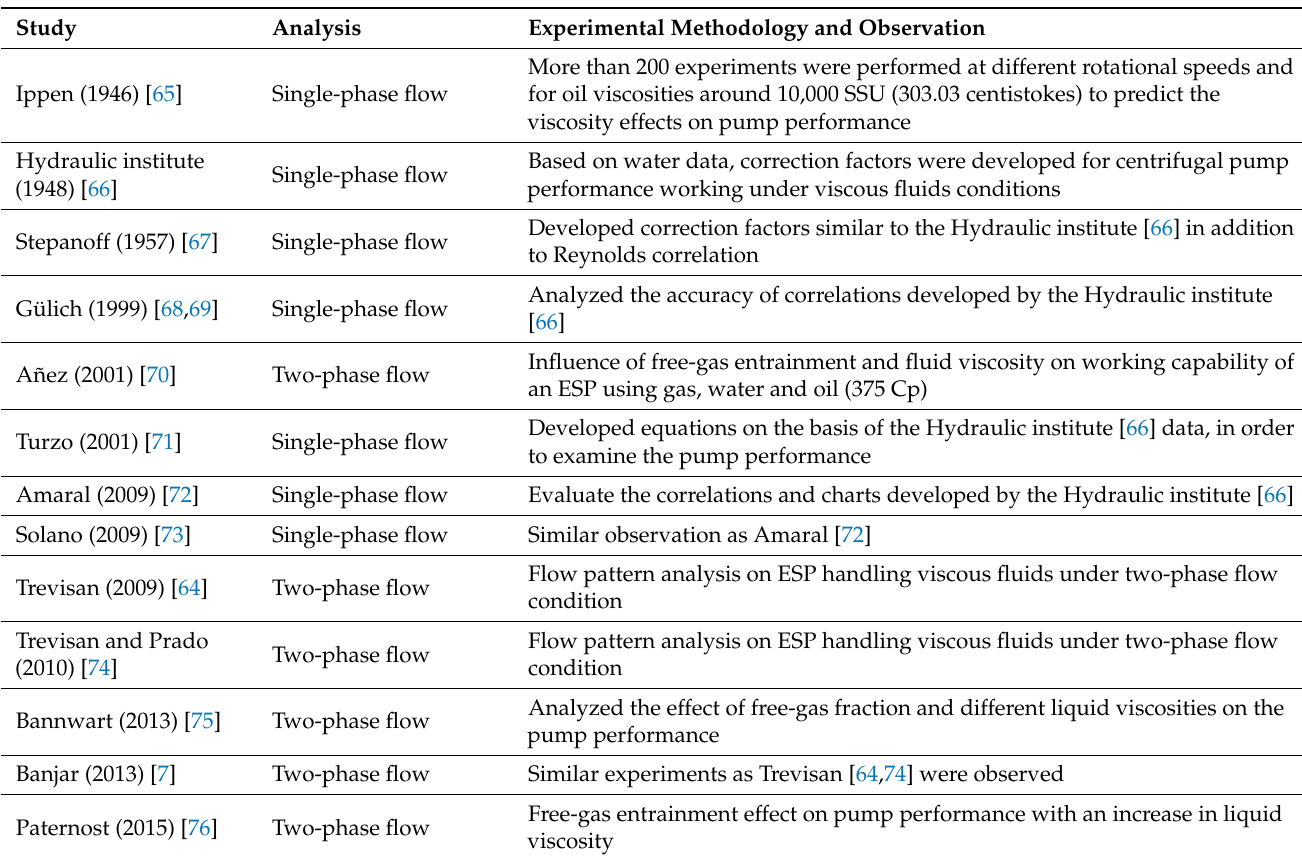
Table 6. Test studies on ESPs handling viscous fluids under single-phase and two-phase flow.